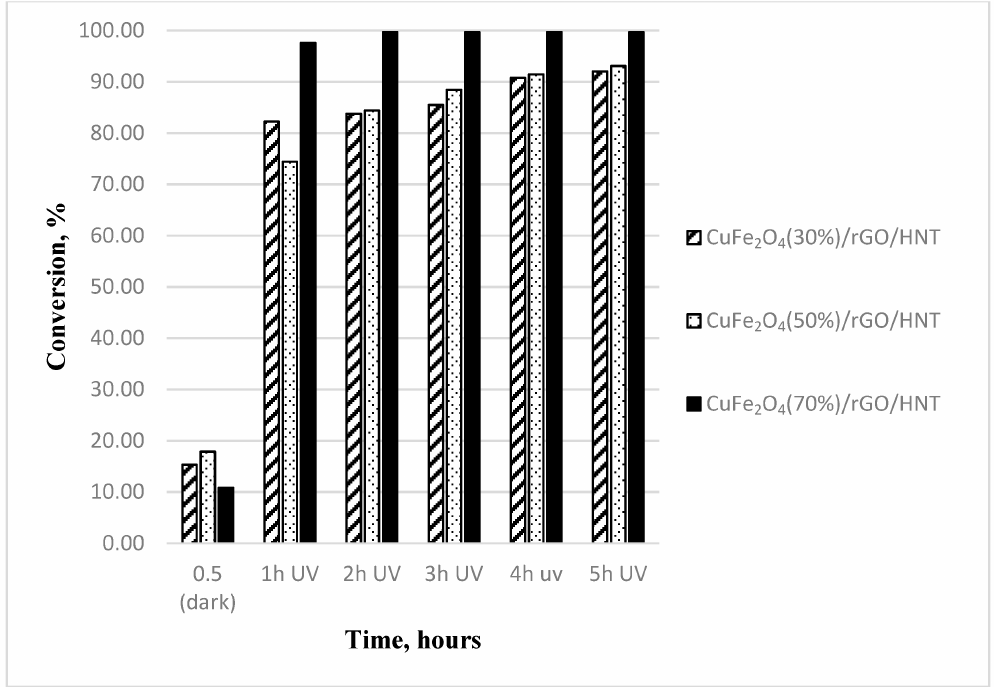
Figure 8. CIP conversion with CuFe 2 O 4 /rGO/HNT series.